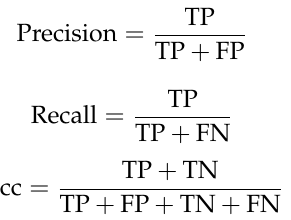
Equation (9) to evaluate the candidate region image patch classification